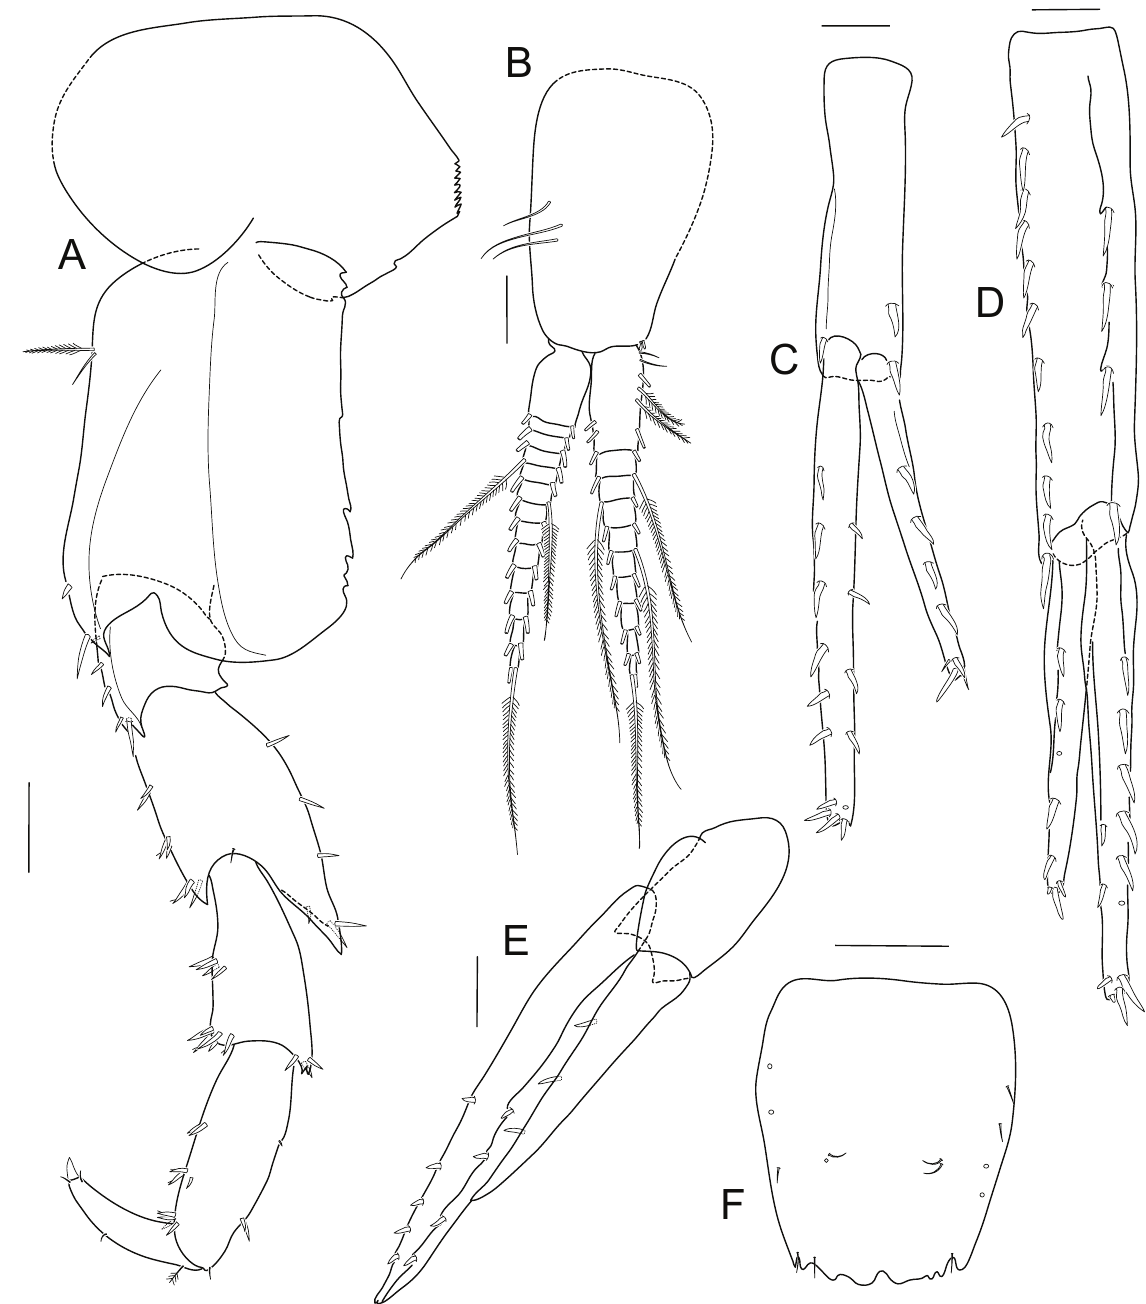
Fig. 11. Labriphimedia martinae nov. sp., holotype ♂, 6.5 mm, NIWA 84743. A . Pereopod 5. B . Pleopod 1. C . right uropod 2. D . Uropod 1. E . Uropod 3. F . Telson. Scale bars: a-F = 100